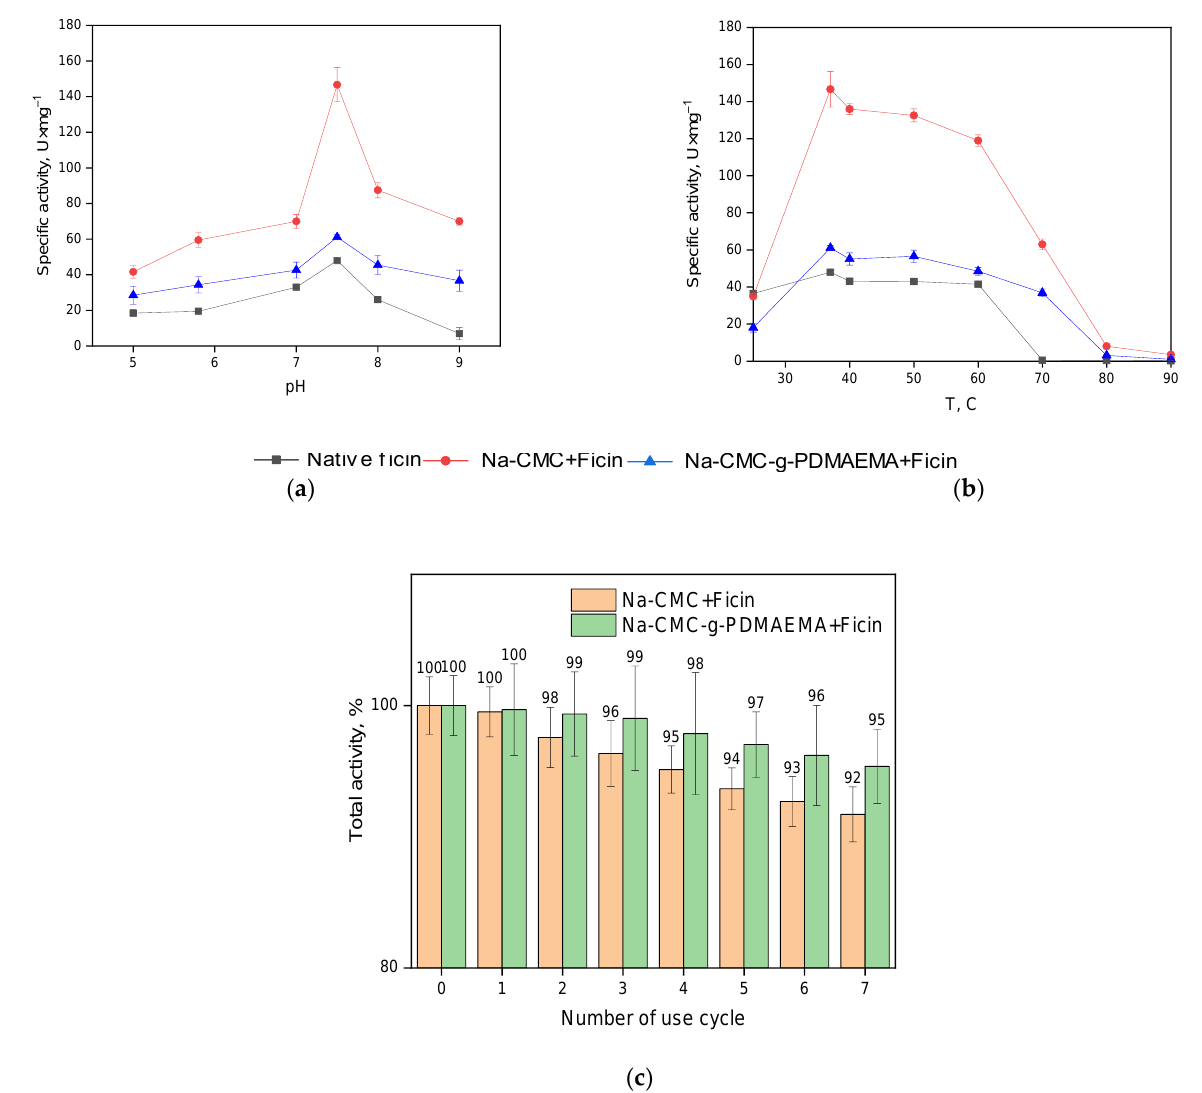
Figure 8. Dependence of ficin specific activity on pH ( a ) and temperature ( b ); the reusability experiments ( c ). Experiments were performed at constant substrate concentration equaled 0.4 % w. Table 3. The kinetic parameters for free and immobilized ficin. Enzyme Formulations